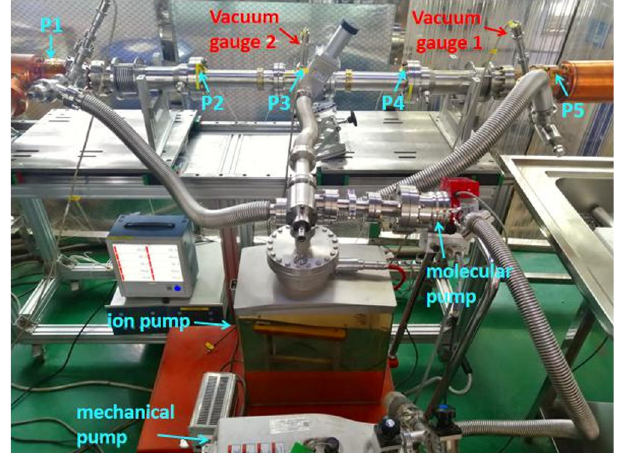
FIG. 20. The proof-of-principle structure of the test system with the vacuum pumping systems. During the high-power tests, region between the two cold windows and that between the cold and warm windows in the right coupler were kept in vacuum, and the data of vacuum gauge 1 and 2 were recorded. P1 to P5 are the positions at which the temperatures were monitored.